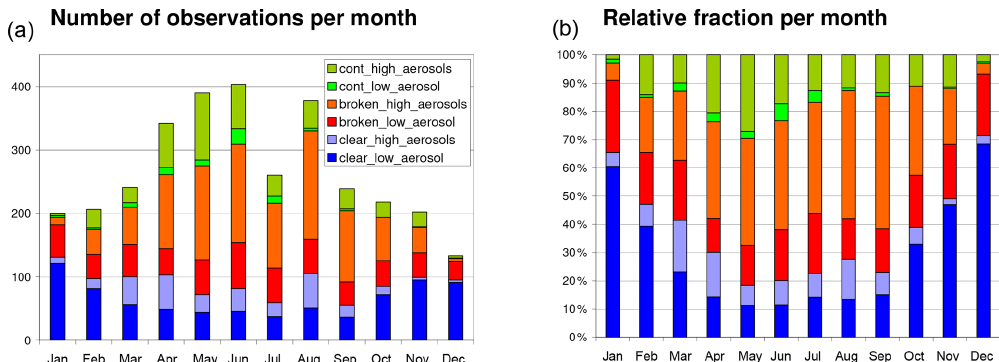
Figure 6. Absolute (a) and relative (b) frequency of the different sky conditions. The statistics is based on the number of observations at a 1 ◦ elevation angle of spectra averaged from 10 original spectra (April 2012–April 2015). Only measurements with more than 800 scans are considered. The basic colors indicate the cloud properties (clear, broken clouds, continuous clouds). The dark or light colors indicate observations with low or high aerosol loads, respectively.